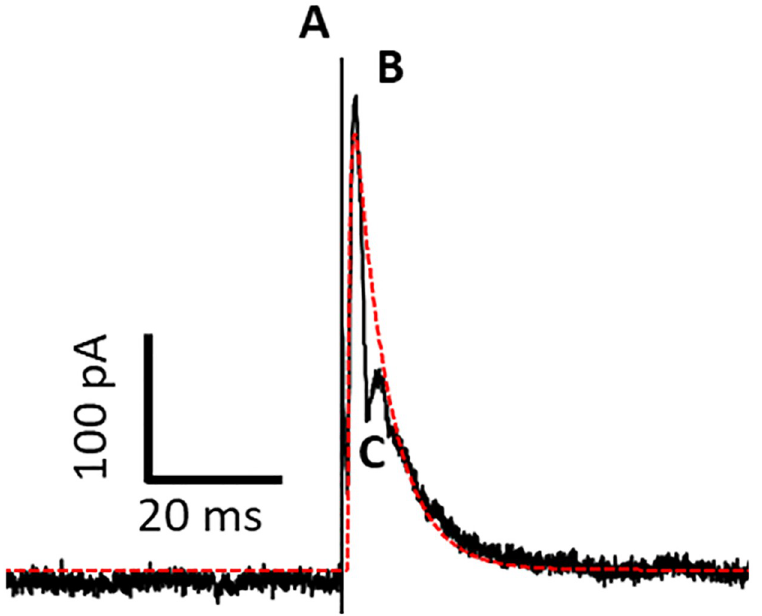
Fig 9. Generating the PSC kernel using a double exponential function. The red line shows the estimated kernel generated by a double exponential function. Black line represents the experimental recordings of the acute slice of the rat STN. A is the stimulation artifact; B is the positive peak of representing the inhibitory response and C is the negative (reversed) peak representing the excitatory response. The difference between PSC signal and the estimated PSC kernel, which is maximized at the reversed excitatory peak, can be considered as the effect of the excitatory